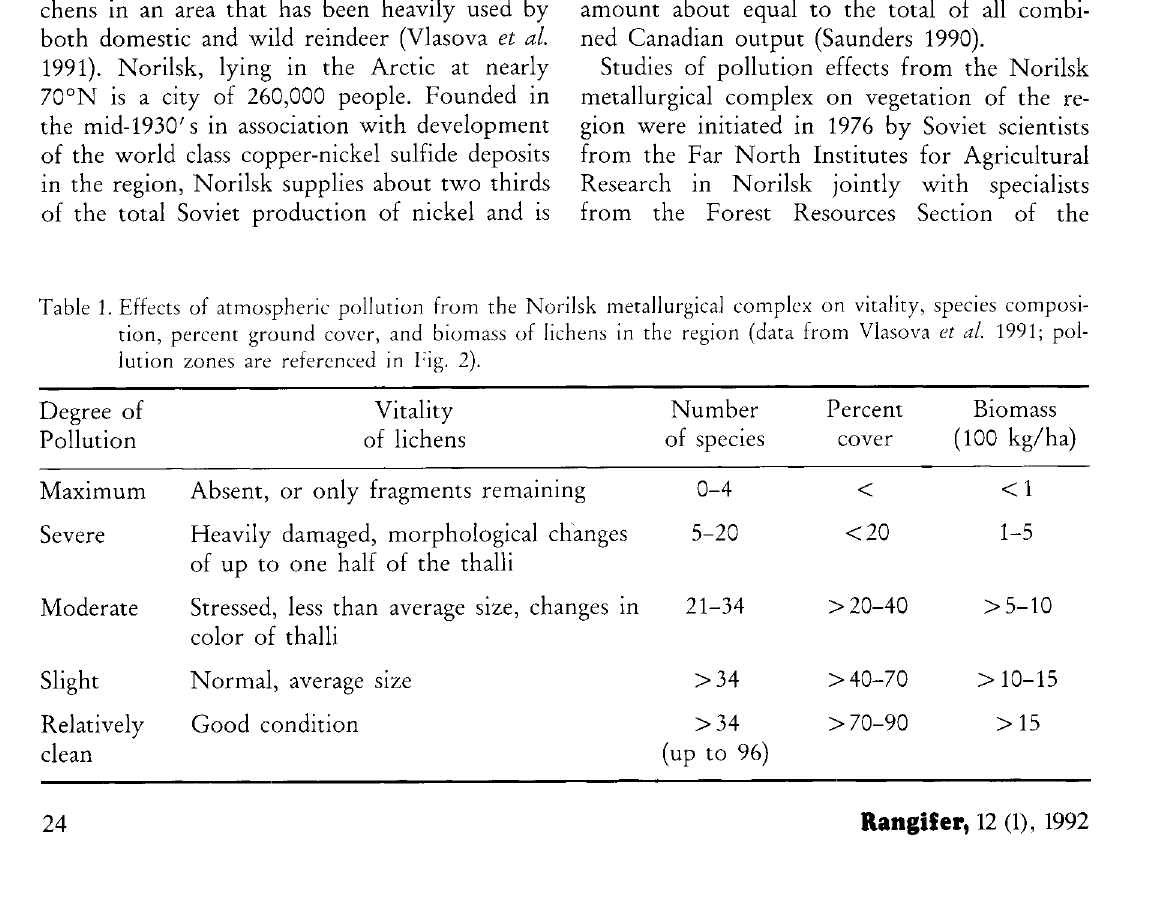
Table 1. Effects of atmospheric pollution from the Norilsk metallurgical complex on vitality, species composi tion, percent ground cover, and biomass of lichens in the region (data from Vlasova et al. 1991; pol lution zones are referenced in Fig.